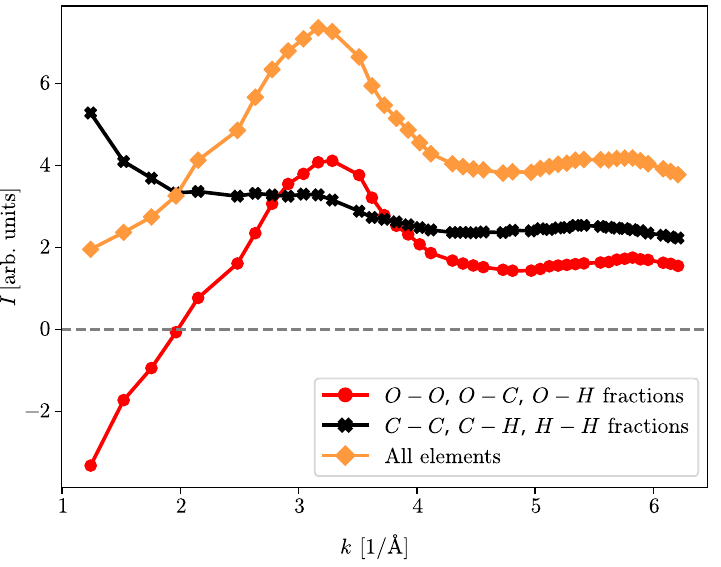
6000 K and P 153 GPa of bindings only = =